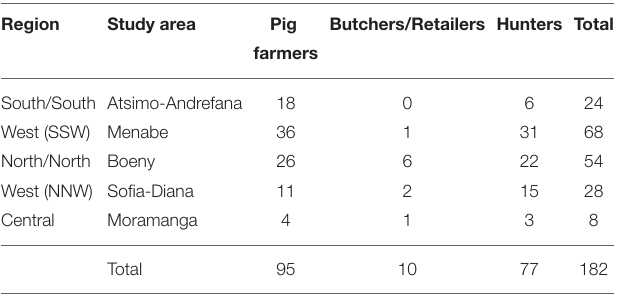
TABLE 1 | Number and type of stakeholders interviewed during a survey on health and socioeconomic aspects of bushpig hunting in Madagascar, 2014 − 2015. Region Study area Pig